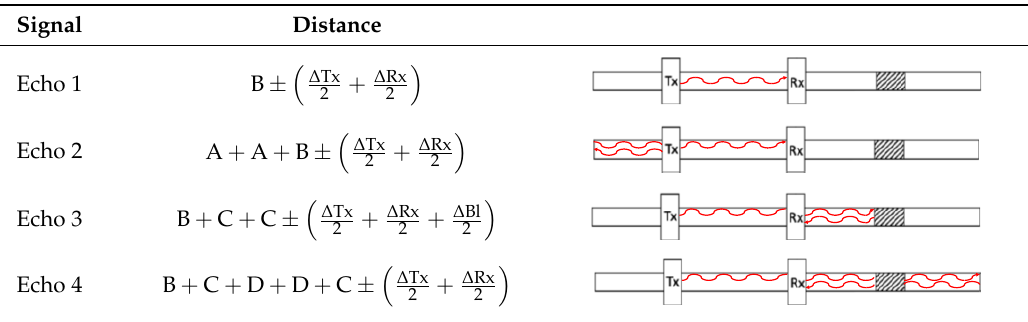
Table 4. Main expected echoes according to Figure 14.